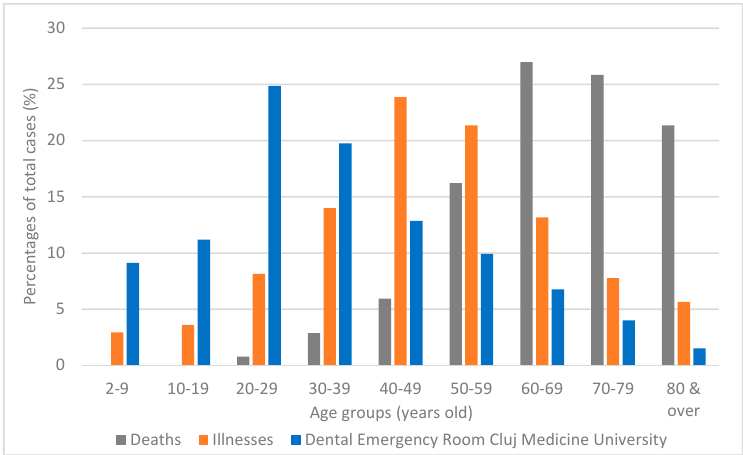
Figure 3. Comparison of the number of COVID-19 deaths/infected persons nationwide with the